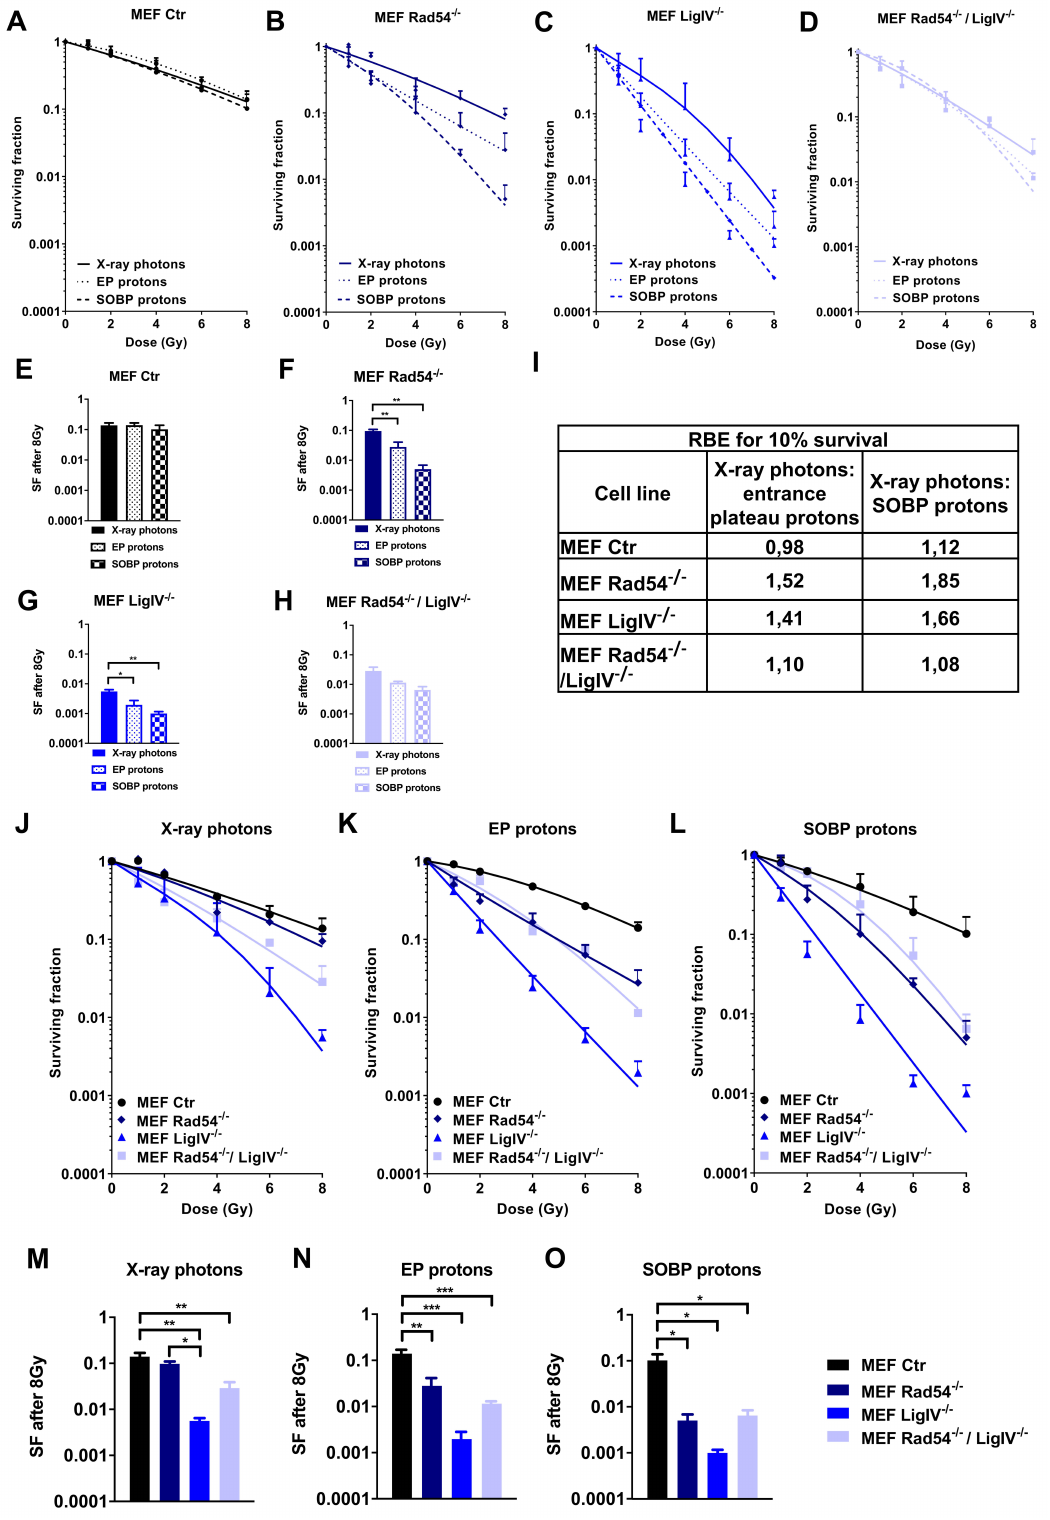
Figure 2. Effects of X-ray photons, EP and SOBP protons on clonogenic cell survival. ( A – H ) Results of colony formation assay in wild type MEFs (Ctr) and MEFs harboring genetic deficiency ( − / − ) in Rad54 (Rad54 − / − ), Lig IV (Lig IV − / − ) or Rad54 and Lig IV (Rad54 − / − / Lig IV − / − ), upon irradiation with X-ray photons, EP protons or SOBP protons (1–8 Gy) as indicated. ( I ) RBE values of clonogenic survival calculated for 10% survival of the indicated MEF cell lines. ( J – L ) Clonogenic survival curves of MEFs upon irradiation with 1–8 Gy of X-ray photons ( J ), EP protons ( K ) or SOBP protons ( L ). ( M – O )